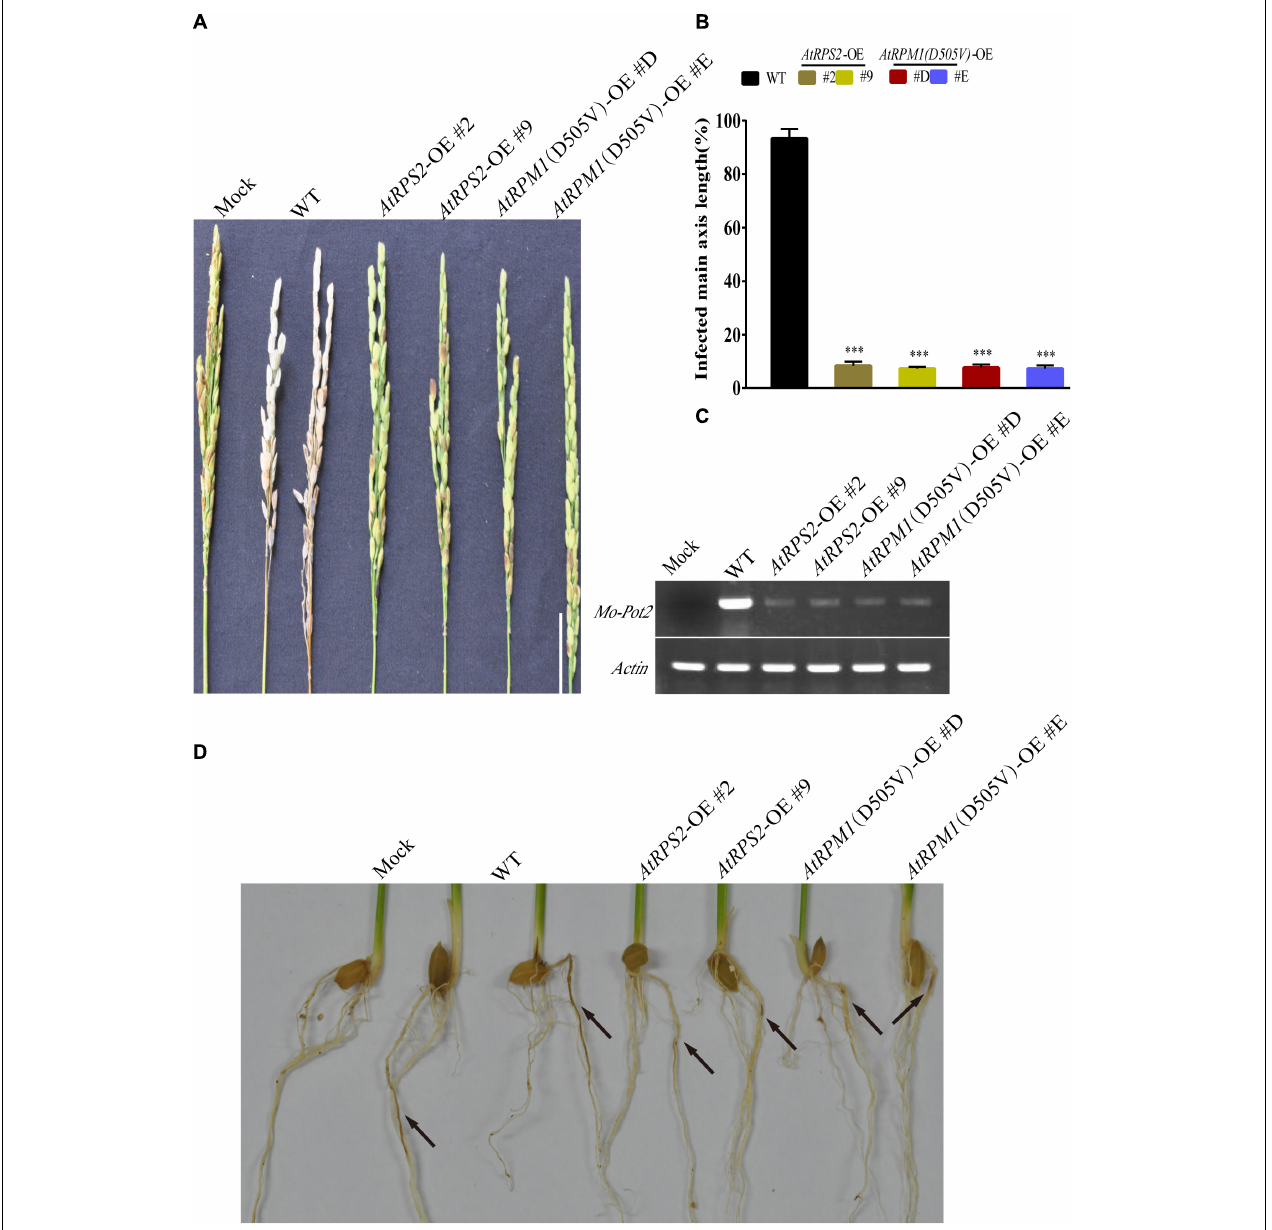
FIGURE 2 | Panicle Blast and Root Blast Infection Assays of the AtRPS2 and AtRPM1 ( D505V ) Transgenic Plants and Nipponbare. (A) Disease phenotypes of the transgenic plants and Nipponbare after inoculation with M. oryzae isolate GC1-4 at the heading stage. Scale bars = 4 cm. (B) Lengths of the diseased main axis in the AtRPS2 , AtRPM1 ( D505V ) transgenic plants and Nipponbare after panicle blast infection. Data are shown as means ± SD ( n = 6). Asterisks represent significant differences (one way ANOVA, ∗∗∗ P < 0.001). (C) The fungal growth in infected panicles was measured by semiquantitative RT-PCR. (D) Disease symptoms on the roots of the transgenic plants and Nipponbare after M. oryzae isolate GC1-4 infection. Seedlings were examined for disease symptoms after 3 weeks incubation. Black arrows indicate the lesions of roots. Similar results were obtained in three independent